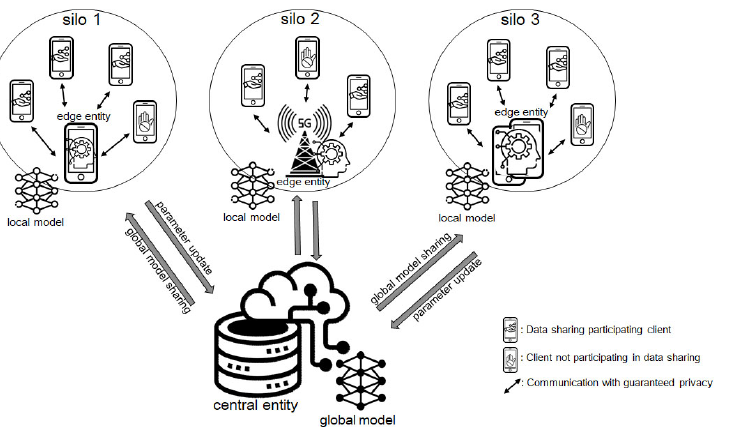
Figure 1. The cross-silo FL model assumed in this paper consists of one central entity and a plurality of edge entities. The edge entity is a form of a coalition between the client(s) and the base station, and a representative part of the component terminals communicates directly with the central entity to participate in global model